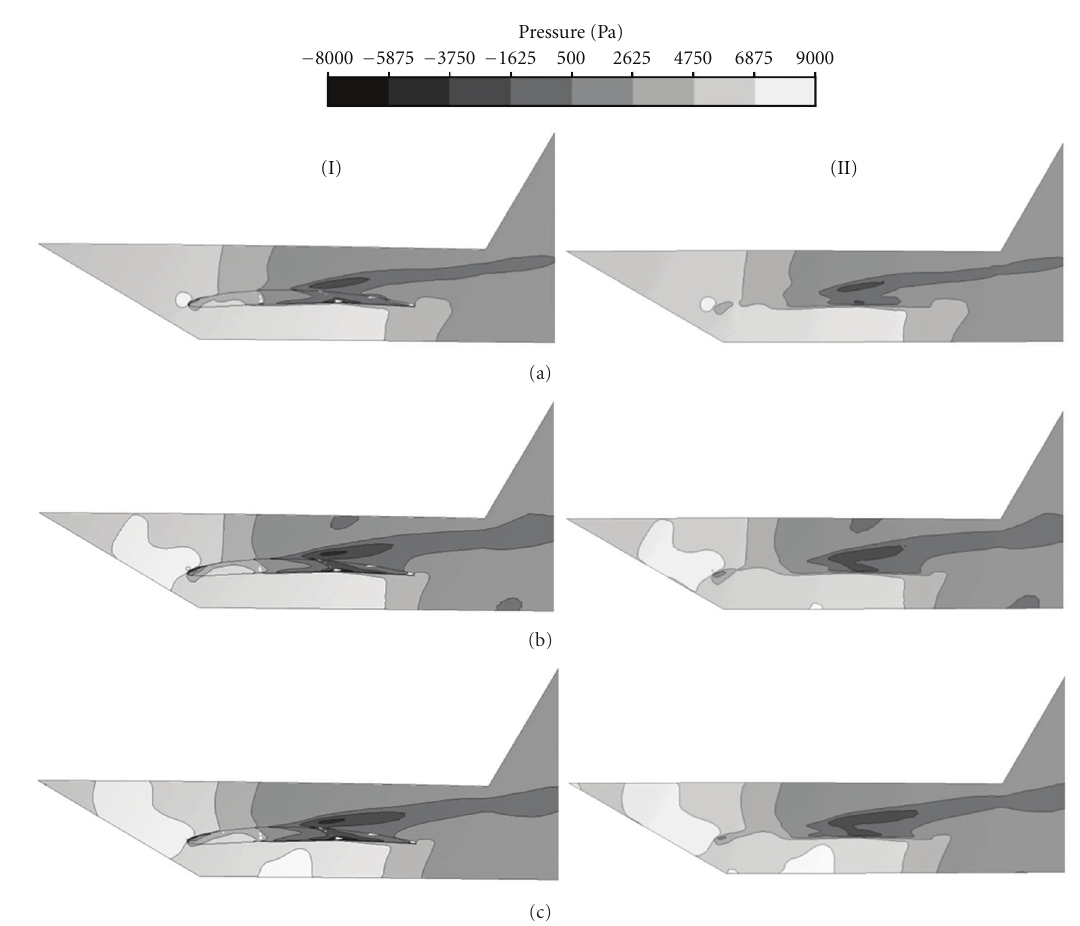
Figure 11: Pressure contours of surface located at (I) blade tip radius and at (II) the casing surface, for the case of 0.5mm gap, when the blade is at (a) maximum deflection, (b) mean deflection, and (c) minimum